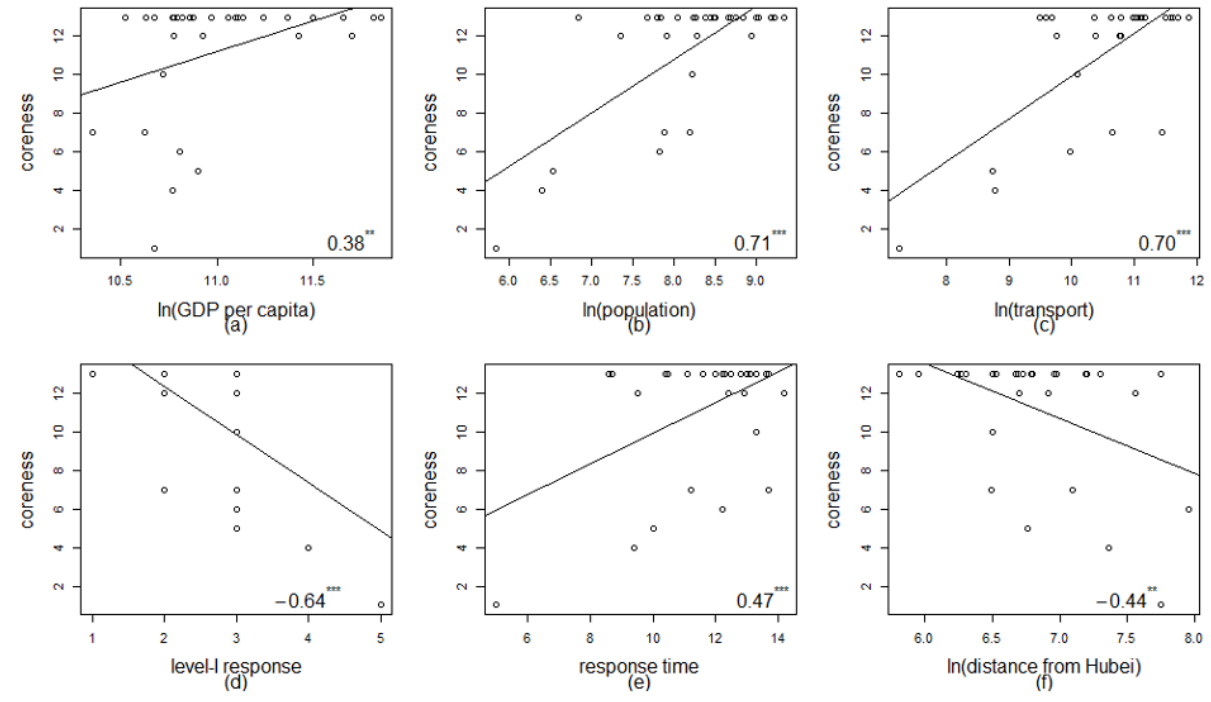
Figure 7. Correlation diagrams of the corenesses and characteristics of the provinces. The horizontal and vertical axes denote the characteristic variables and corenesses, respectively. The numbers in the lower right corner of each subgraph are the corresponding correlation coefficient. **5% significance, ***1% significance.